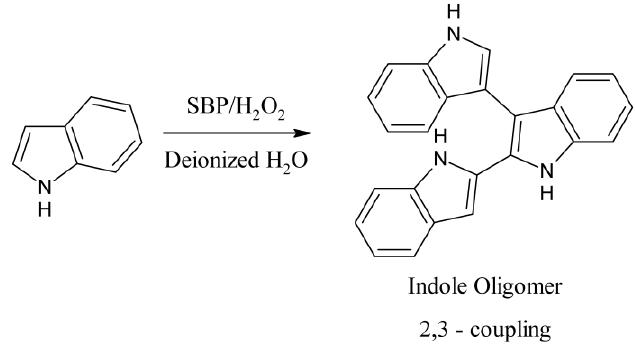
Figure 2. Reaction scheme and proposed coupling route for the biocatalytic polymerization of indole with